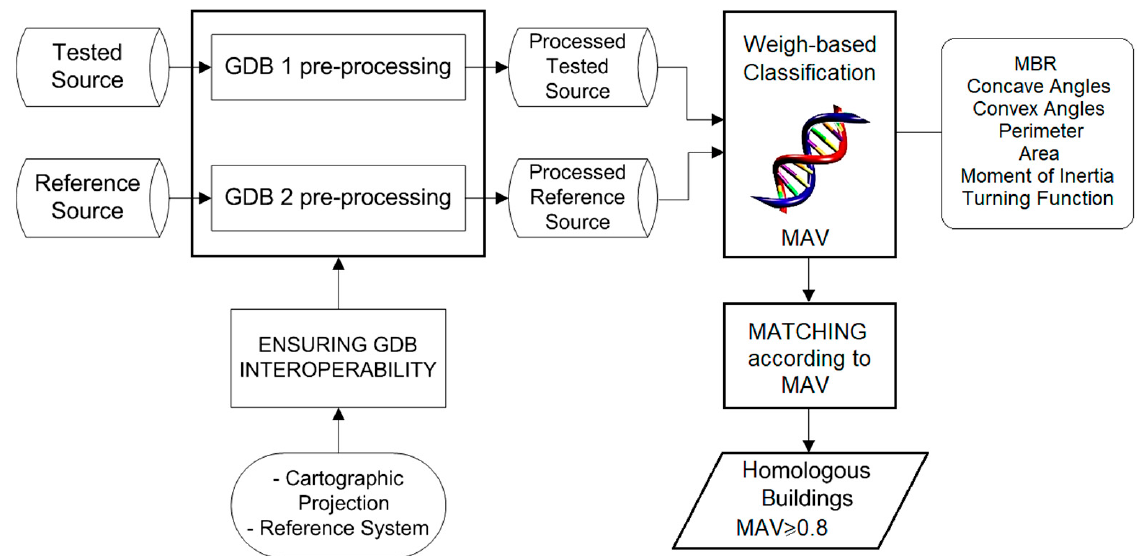
Figure 3. Workflow of the automated matching procedure.